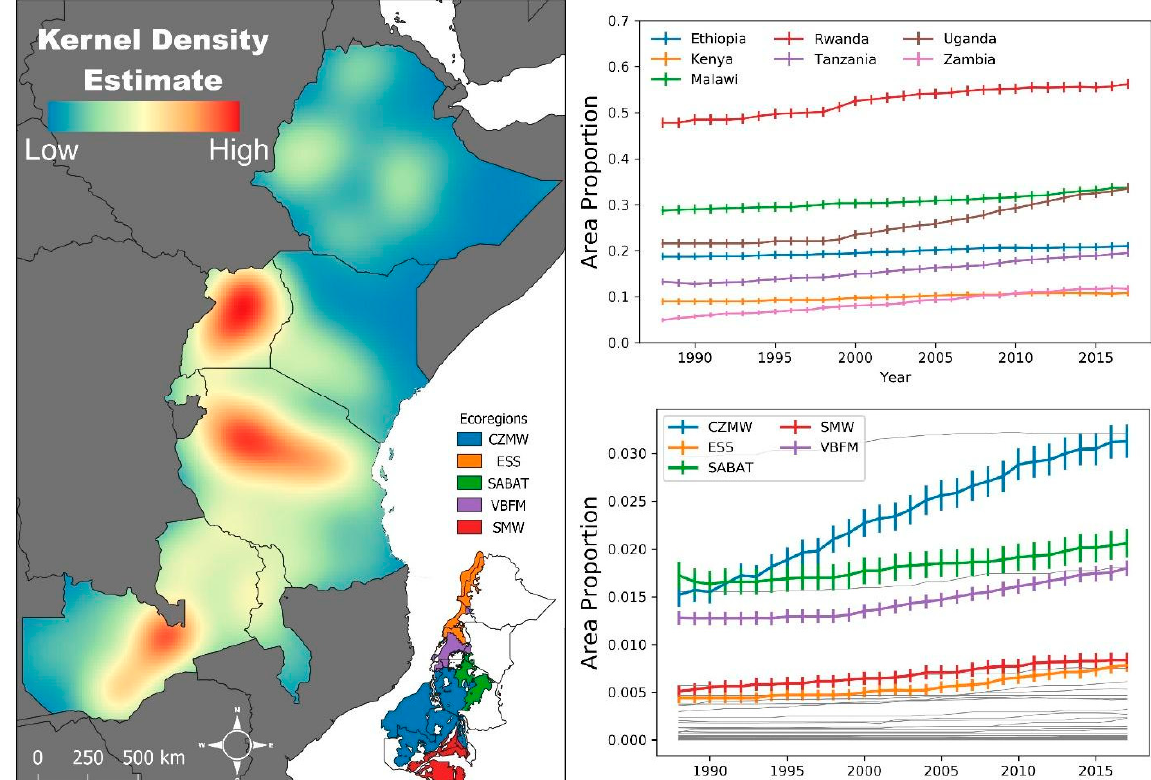
Figure 5. Cropland gain in East Africa. Left: Kernel Density hotspot analysis of new cropland. Top, proportional change of Cropland in seven countries. Bottom, Proportional change of Cropland in ecoregions in which the five ecoregions with the greatest change are colored (CZMW, Central Zambezian Miombo Woodlands, ESS, East Sudanian Savanna, SMW, Southern Miombo Woodlands, SABAT, Southern Acacia-Commiphora Bushlands and Thicklets, VBFM, Victoria Basin Forest-Savanna Mosaic). The grey lines represent the other ecoregions.